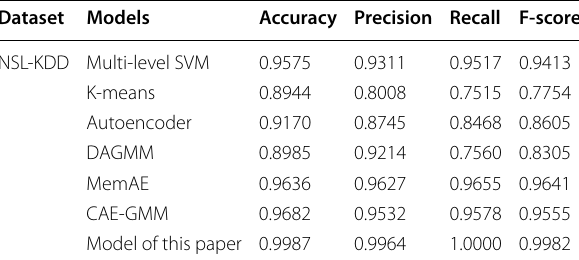
Table 4 Comparison of the results of each anomaly detection algorithm under the NSL-KDD dataset Dataset Models